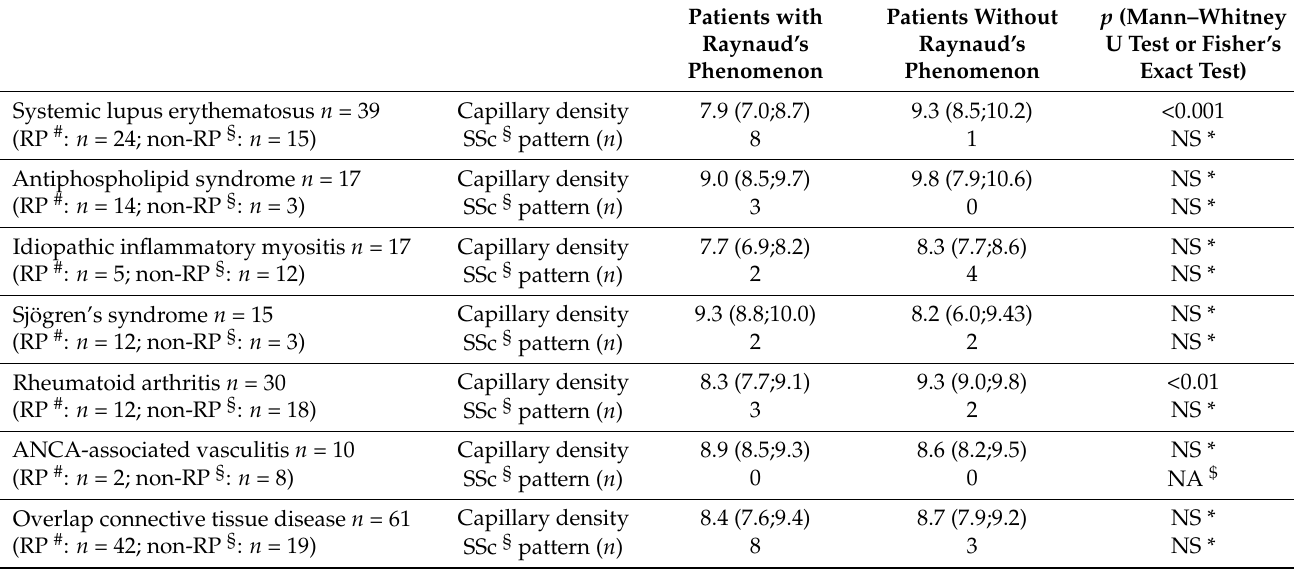
CTD c with different